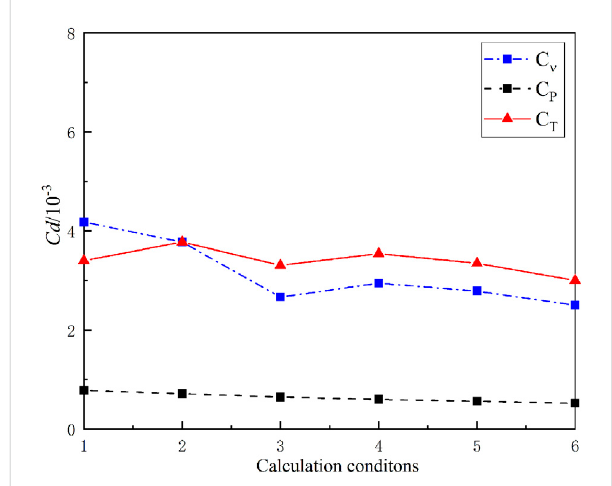
FIGURE 6 Coef fi cient drag of the SUBOFF models under different